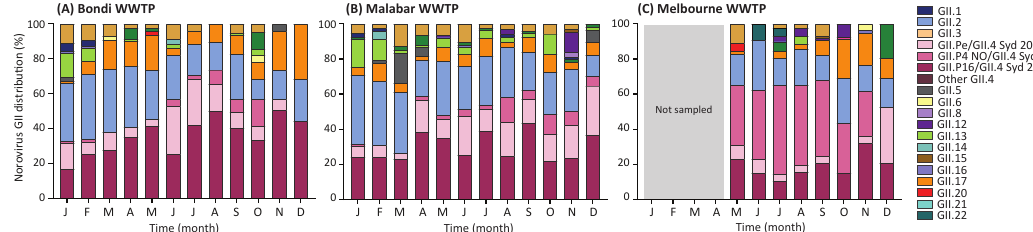
Figure 7. Norovirus GII genotype distribution in wastewater samples collected from Sydney and Melbourne, 2017. The norovirus GII capsid genotypic distribution was determined in wastewater samples by amplicon sequencing using NGS technology. After amplification of the capsid region, a second round PCR was performed for the addition of adapters prior NGS library preparation. Libraries were sequenced on the MiSeq platform and an average of 152,879 reads were generated for each sample. Geneious was used for merging and mapping of the reads to the norovirus GII reference sequences. ( A ) The monthly genotype distribution of norovirus GII viruses in wastewater samples collected from Bondi WWTP in Sydney, Australia. ( B ) Norovirus GII genotypic diversity was examined in wastewater samples collected monthly from Malabar WWTP in Sydney, Australia. ( C ) The monthly norovirus GII genotype diversity was also examined in Melbourne, all samples were collected from western wastewater treatment plant. Samples were not collected between January and April 2017. Norovirus GII capsid genotype and GII.4 recombinants are labelled in different colors as indicated by the